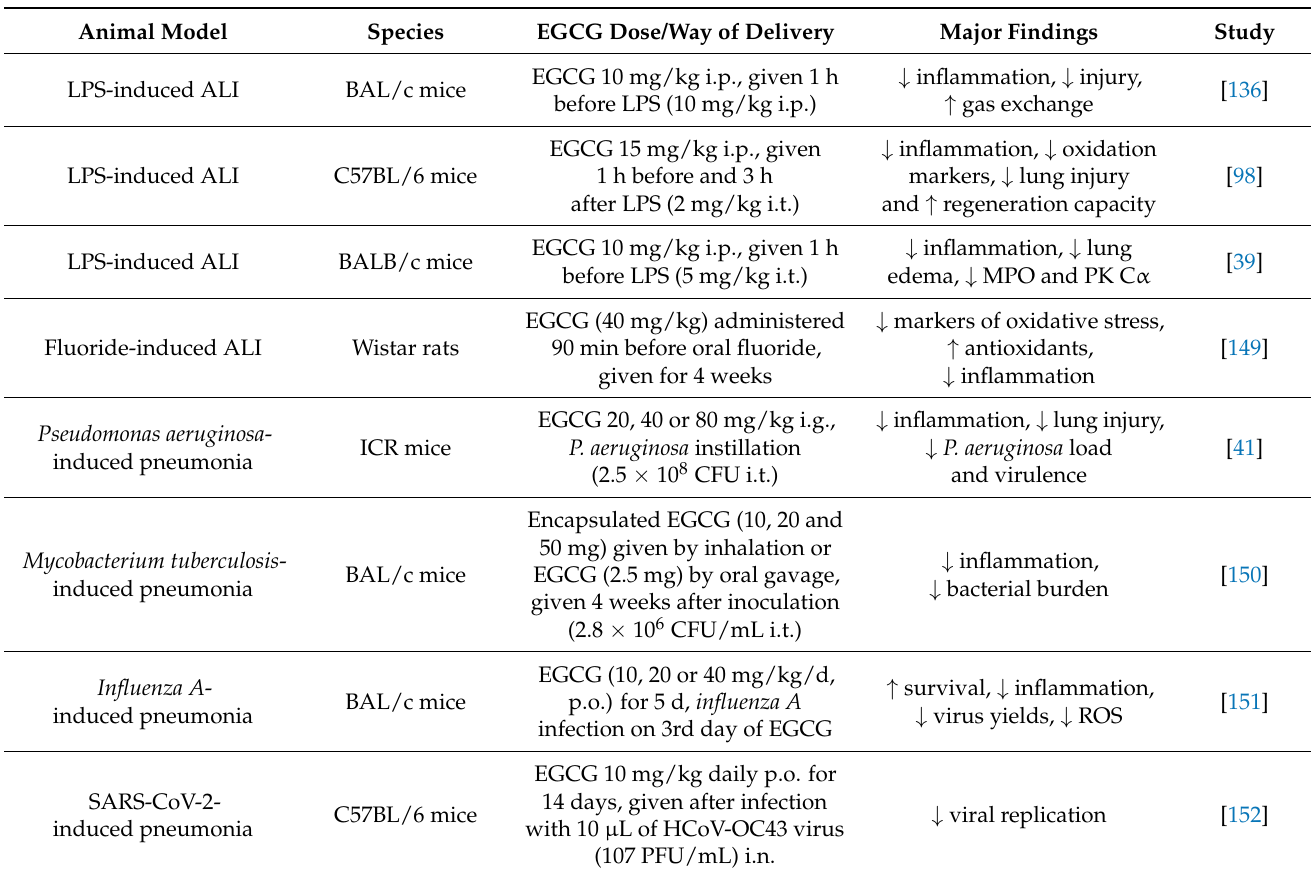
Table 2. EGCG in the treatment of acute lung injury and respiratory infections including COVID-19 (animal models). For more details, see the